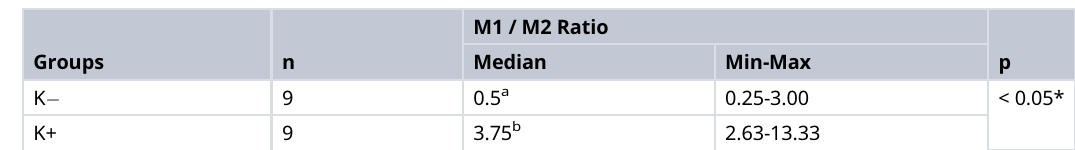
Table 4. M1 / M2 ratio in K (cid:2) and K+ groups.